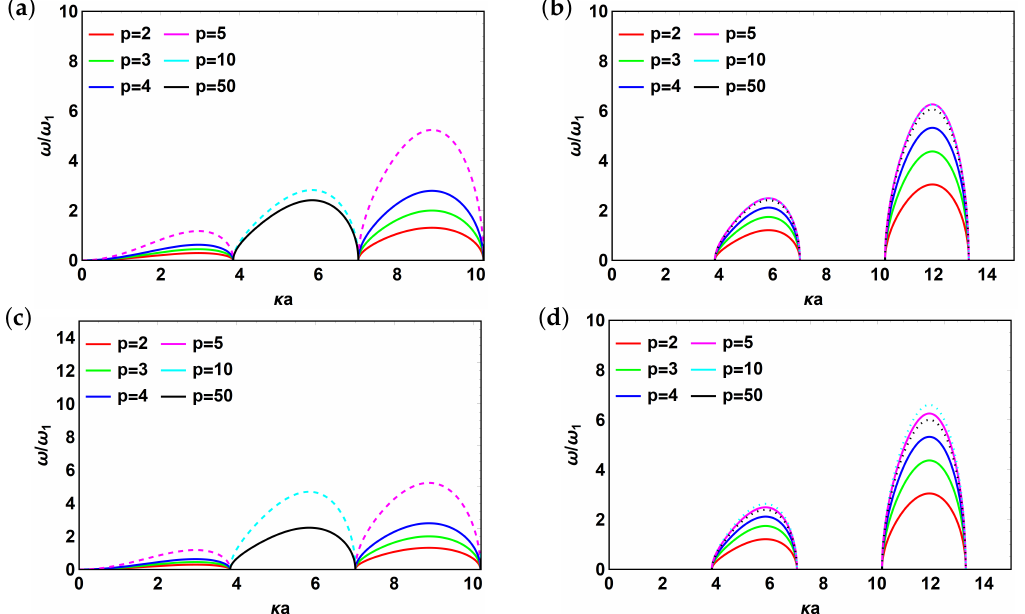
Figure 5. Dispersion relation for metascreen ( a ) w/2 interfaces and w/reflector ( r 0 = 0.5), kh (cid:28) 1, δ (cid:28) 1, “negative” branch; ( b ) w/2 interfaces and w/reflector ( r 0 = 0.5), kh (cid:28) 1, δ (cid:28) 1, “positive” branch; ( c ) w/2 interfaces and w/reflector ( r 0 = 0.5), kh (cid:28) 1, “negative” branch; ( d ) w/2 interfaces and w/reflector ( r 0 = 0.5), kh (cid:28) 1, “positive” branch. For all plots n = 1, q = 2. Dashed lines in ( a , c ) are used to demonstrate switching between modes; dotted lines in ( b , d ) demonstrate the largest resonant peak for various configurations of metamaterial and compare it with the case of independent scatterers (black